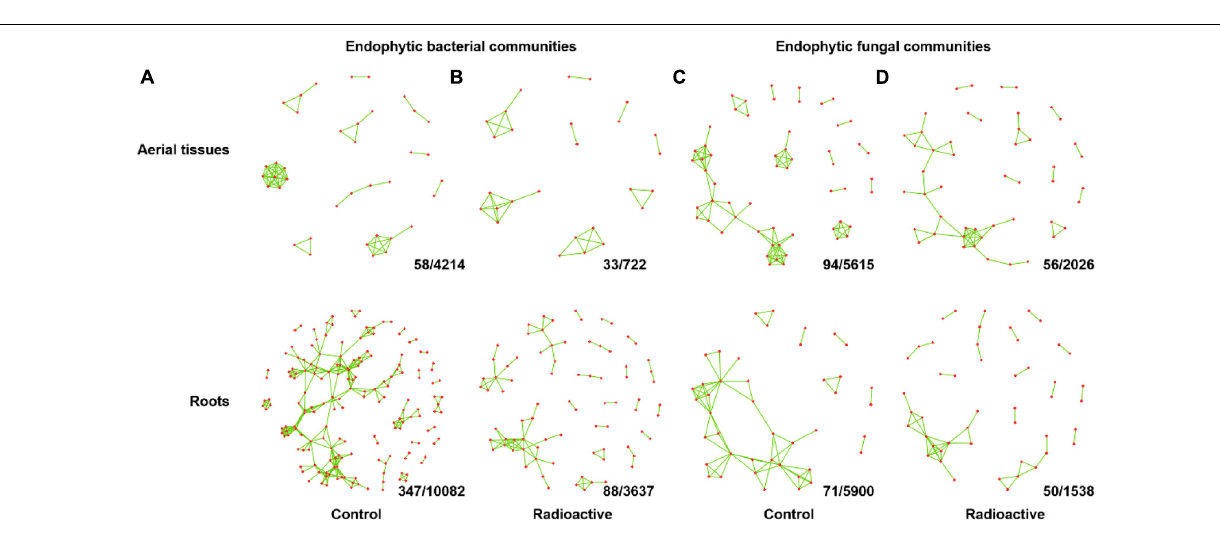
FIGURE 7 | Combined network showing co-occurrence relationships among endophyte communities in two or more seasons. The inter taxa co-occurrences of endophytic bacterial communities in each season at the control site (A) or radiation stressed site (B) were counted, and co-occurrences relationships presented in only one season were removed. Combined network of endophytic fungal communities at the control site (C) and radiation stressed site (D) were generated using the same method. Values at the bottom right of each grid indicate the number of co-occurrence relationships presented in no less than two seasons/numbers of co-occurrence relationships presented in at least one season. See Supplementary Table 4 (bacteria) and Supplementary Table 5 (fungi) for counterparts of each co-occurrence relationship in the network